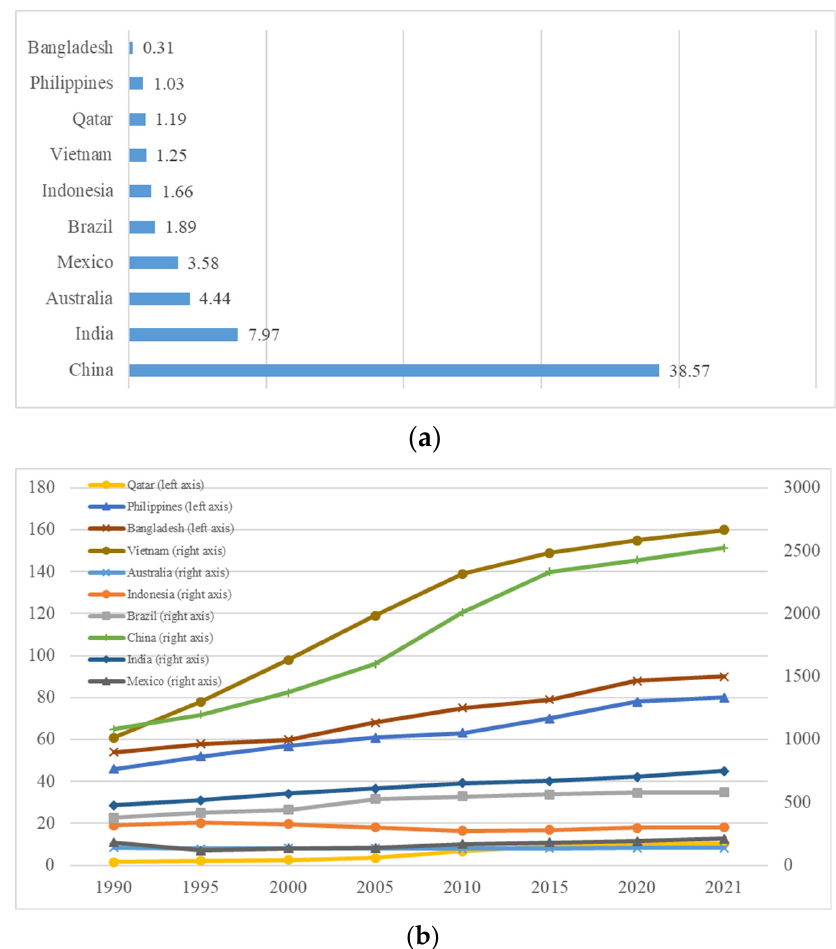
Figure 3. ( a ) Average CO 2 emissions (tons per capita) (1990–2021). ( b ) CO 2 and non-CO 2 GHG emissions from 1990 to 2021.